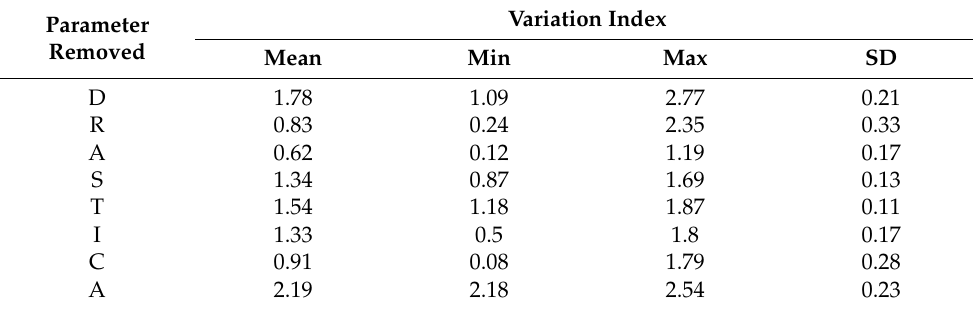
Table 6. Outcomes of the map removal sensitivity analysis after removal of factors.